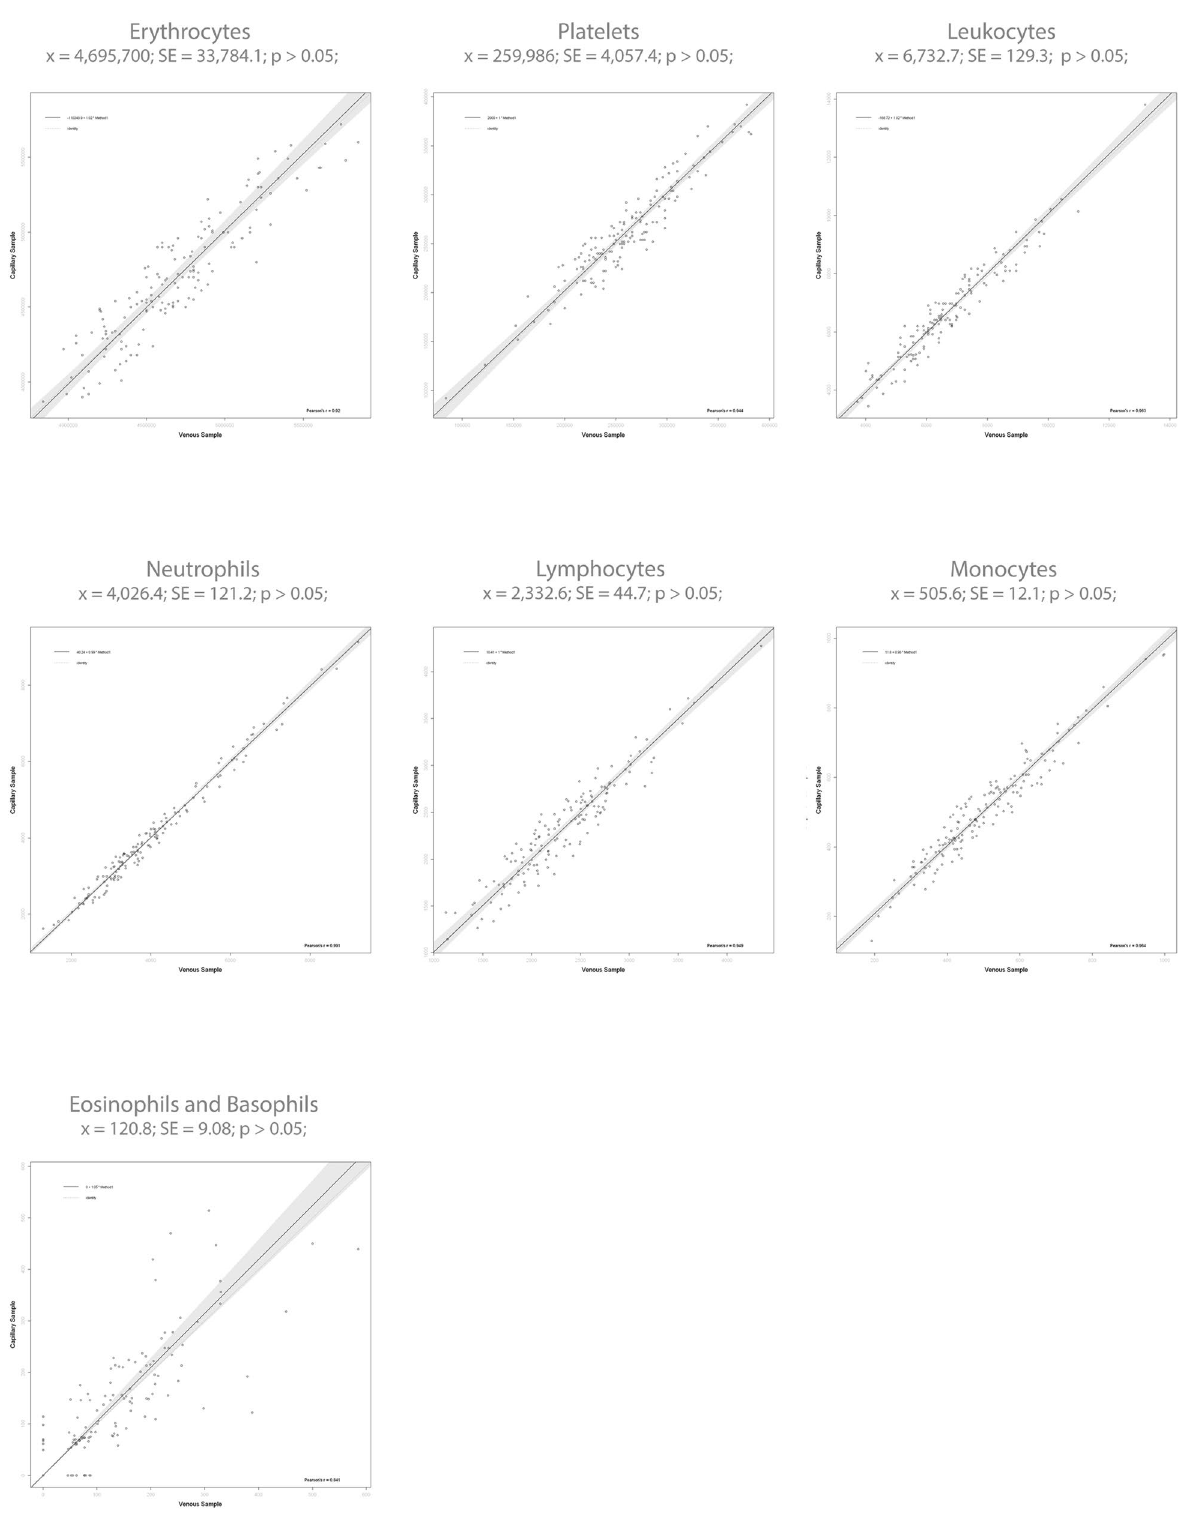
Figure 3. Anticoagulant influence and the effect of sample type. Graphs indicate the Hilab system results for venous (plus K 3 EDTA) × fingerstick blood samples. Mean ( x ), standard deviation (SD), and p-values of Paired Student t test are demonstrated for each